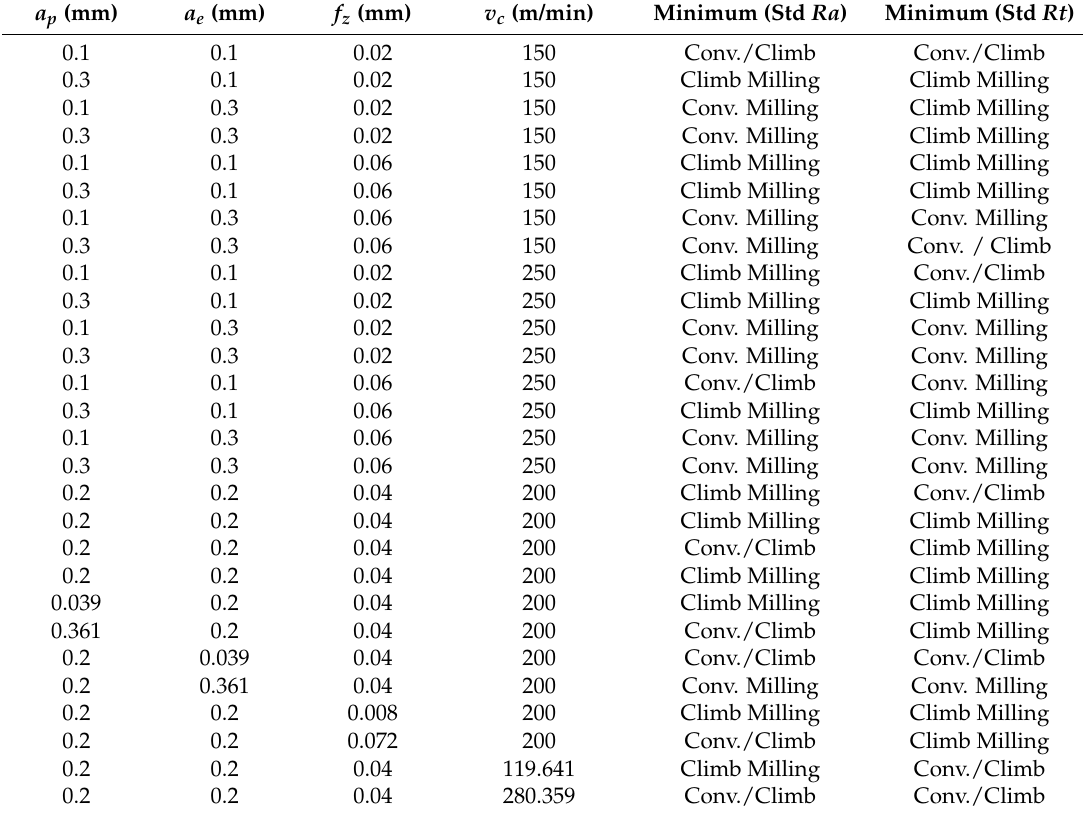
Table 4. Optimal machining strategy